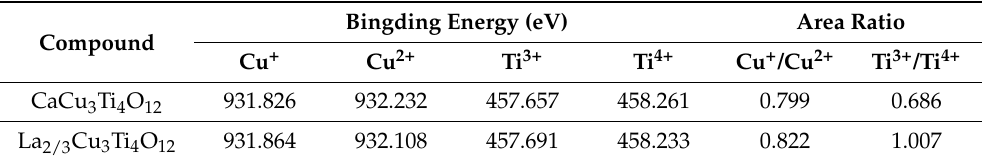
Figure 7. XPS of the Ti ( a ) and Cu ( b ) ions of La 2/3 Cu 3 Ti 4 O 12 and CaCu 3 Ti 4 O 12 ceramics, indicating the polyvalence Ti 3+ /Ti 4+ and Cu + /Cu 2+ . Table 3. XPS parameters of CaCu 3 Ti 4 O 12 and La 2/3 Cu 3 Ti 4 O 12